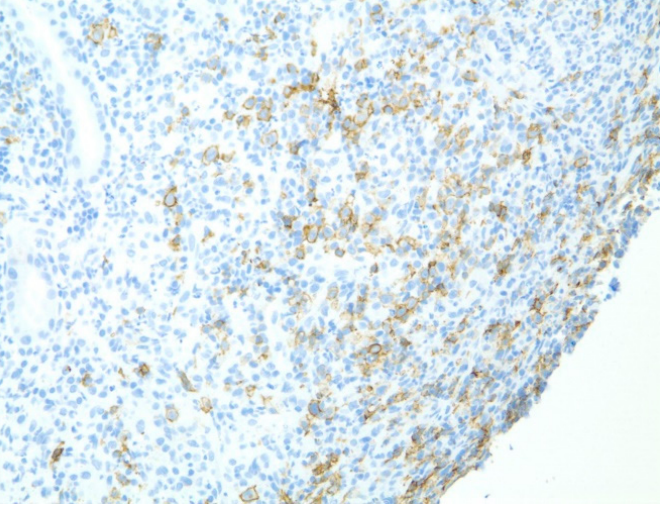
Figure 10. Immunohistochemical stain CD20 stained sections showing atypical large B-cells sugges- tive of marginal zone lymphoma with positive CD20 expression (seen at 200× magnification). An 84-year-old male with multiple comorbidities presented with early satiety and weakness presented for evaluation for a 6 cm gastric mass noted on a CT scan. EGD revealed about 5 cm large ulcerated, necrotic gastric mass with extension to about 1 cm below the GE junction (Figure 11). Additional gastric nodules were seen concerning for satellite lesions. Biopsies from the gastric mass were consistent with diffuse large B-cell lymphoma (Figures 12 and 13). A 66-year-old female presented for endoscopic evaluation of progressive dysphagia to solids and liquids. CT scan showed a heterogeneous necrotic mass in the upper medi- astinum with sub-carinal and left hilar masses along with mass-effect and encasement of mediastinal structures as well. EGD showed a large eroding posterior mediastinal mass was seen starting 22 cm from incisors (Figure 14). Large amount of fluid/pus in the cavity which suctioned easily. The stomach had innumerable polypoid-appearing lesions with superficial ulcers/erosions (Figure 15). Antrum was relatively spared. Nodular duodenitis was seen in the examined portion of the duodenum. Gastric biopsies revealed changes consistent with malignant melanoma (Figure 16).